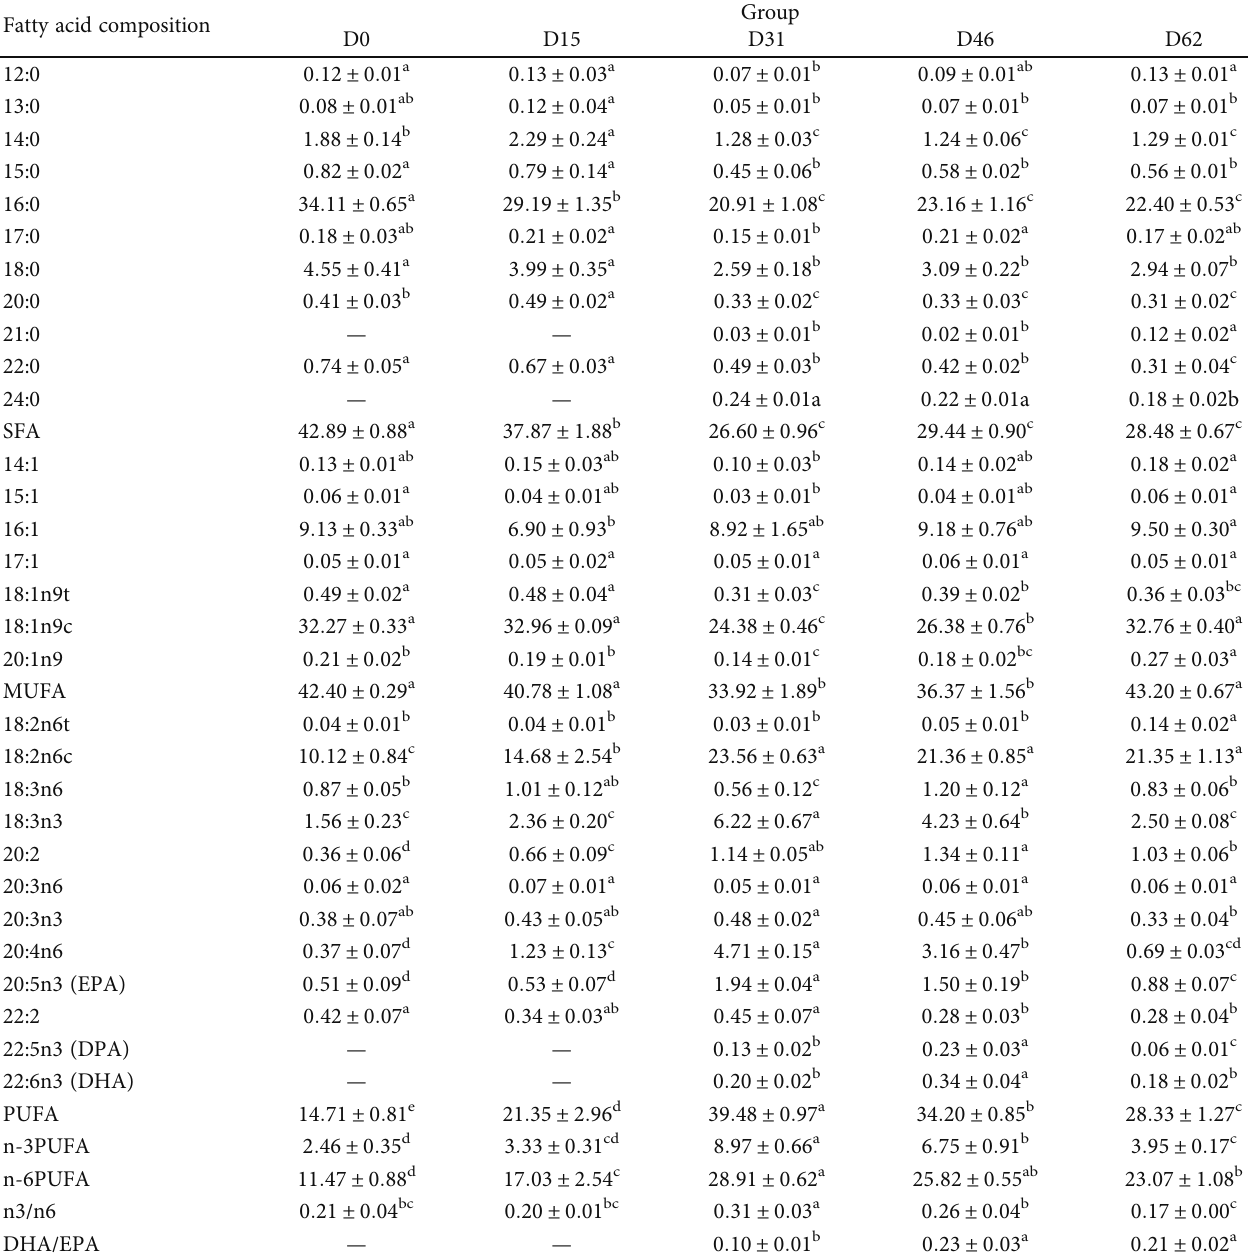
Table 8: Fatty acid composition of female E. sinensis hepatopancreas in rice-crab coculture system at di ff erent developmental periods (% dry